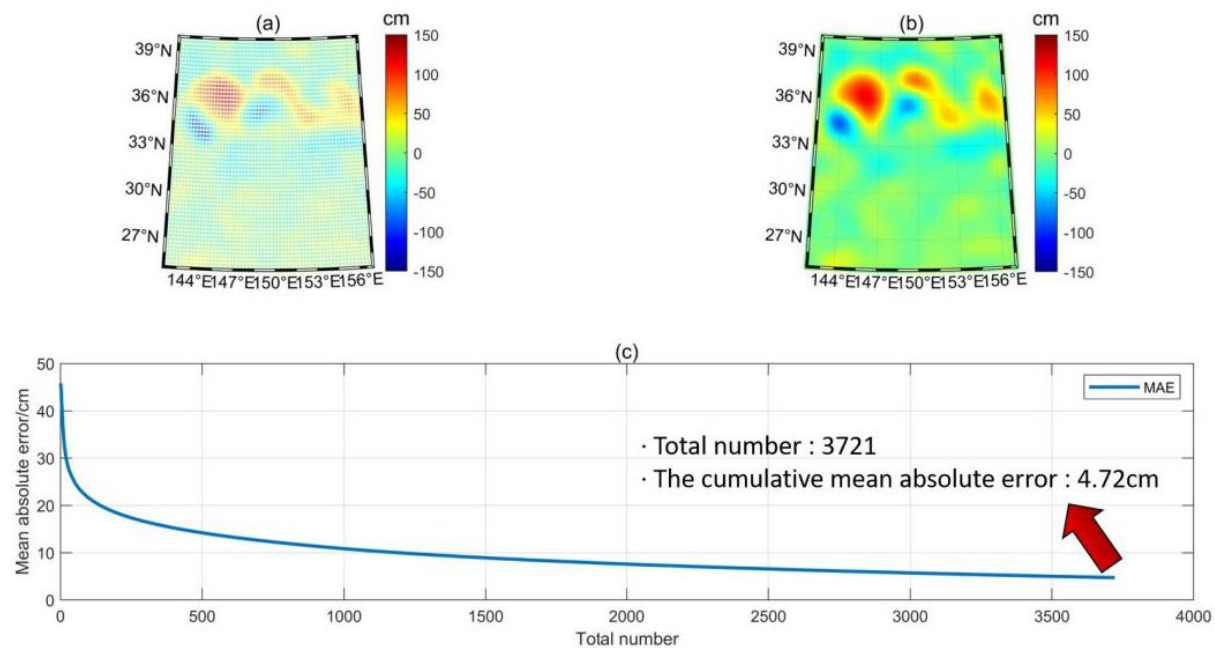
Figure 18. ( a ) Initial sea level anomaly gridded reanalysis data. ( b ) The B-spline surface fitting result. ( c ) The cumulative absolute error curve.